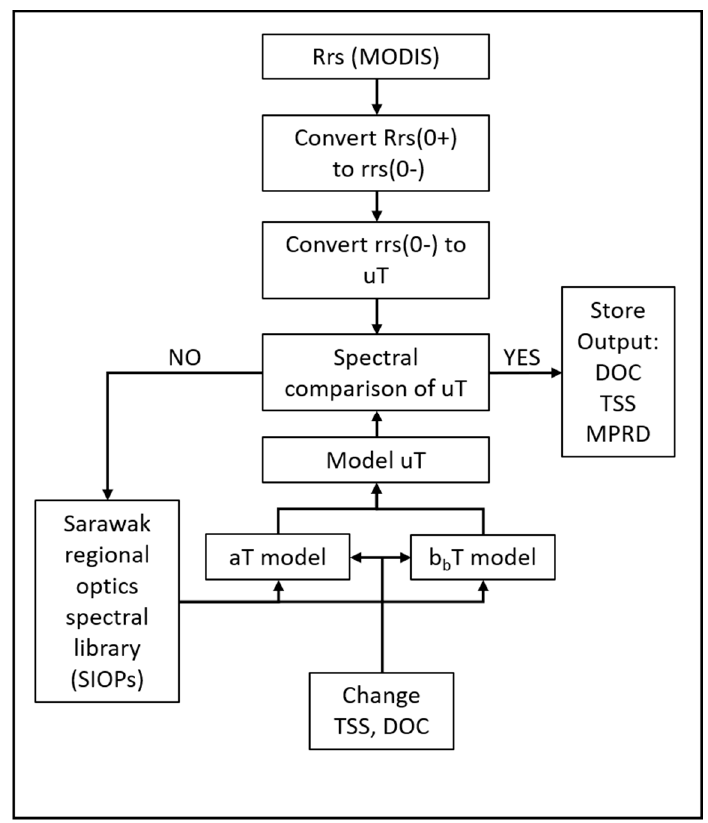
Figure 2. Flow chart of the optical remote sensing inversion approach.